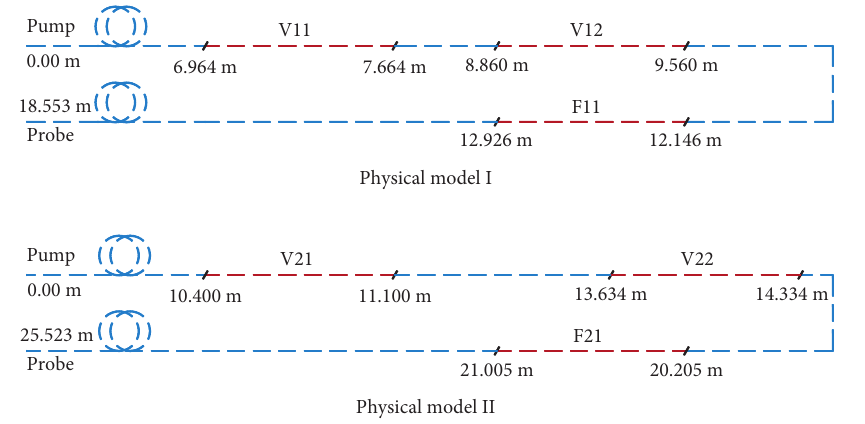
Figure 4: Positioning of sensing optical